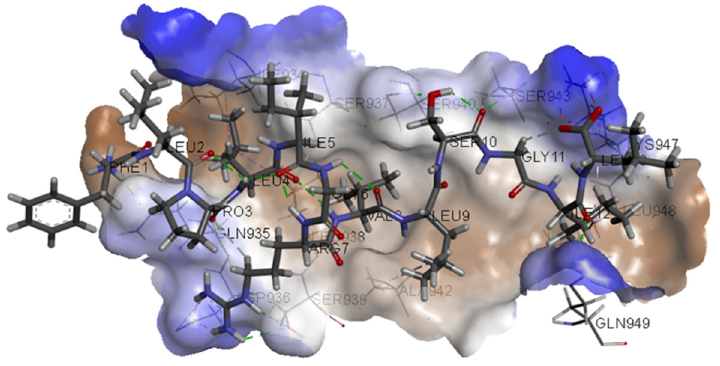
Figure 10. Calculated 3D interactions of AP00094 in complex with SARS-CoV-2’s HR1